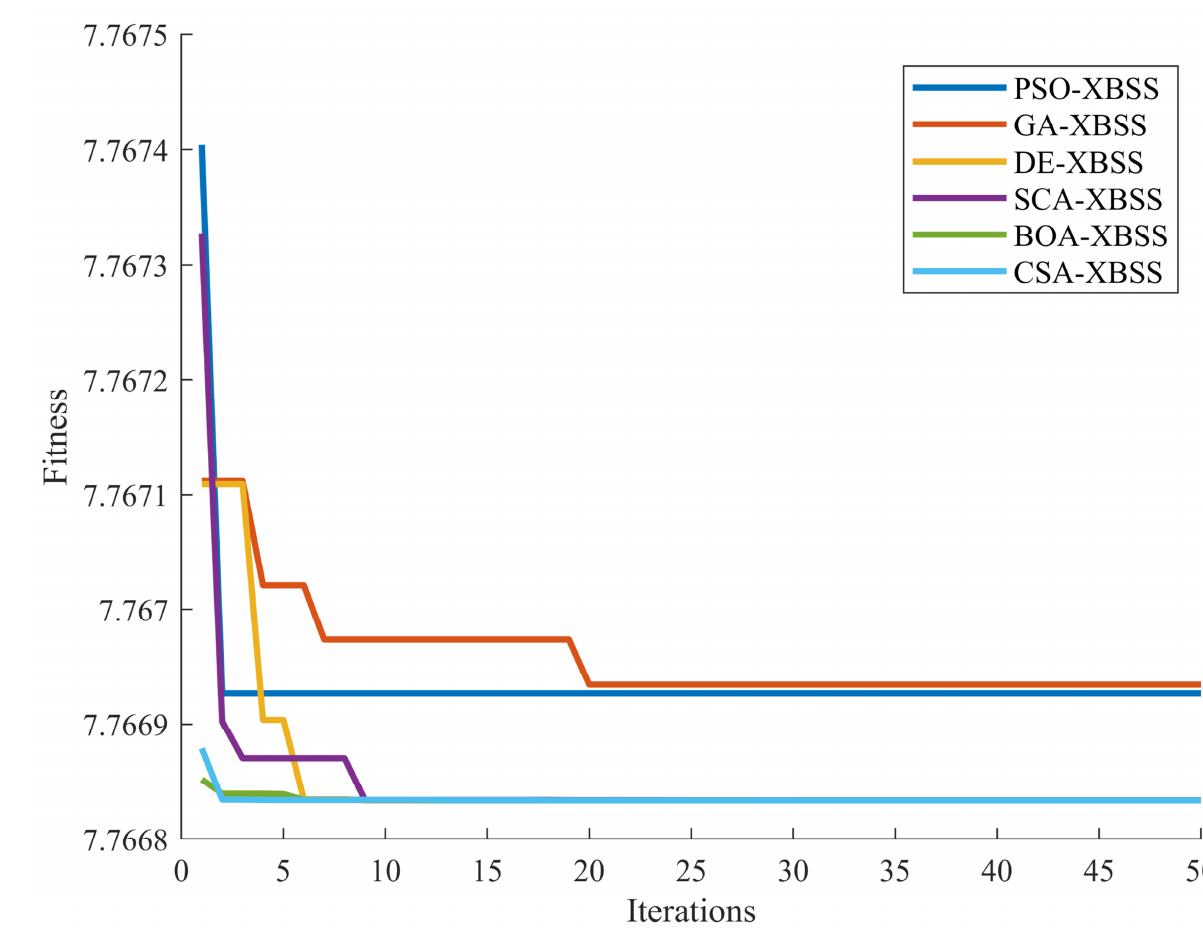
value of our method, and BSS-Xcorr was the cross-correlation value of the SI-BSS.).